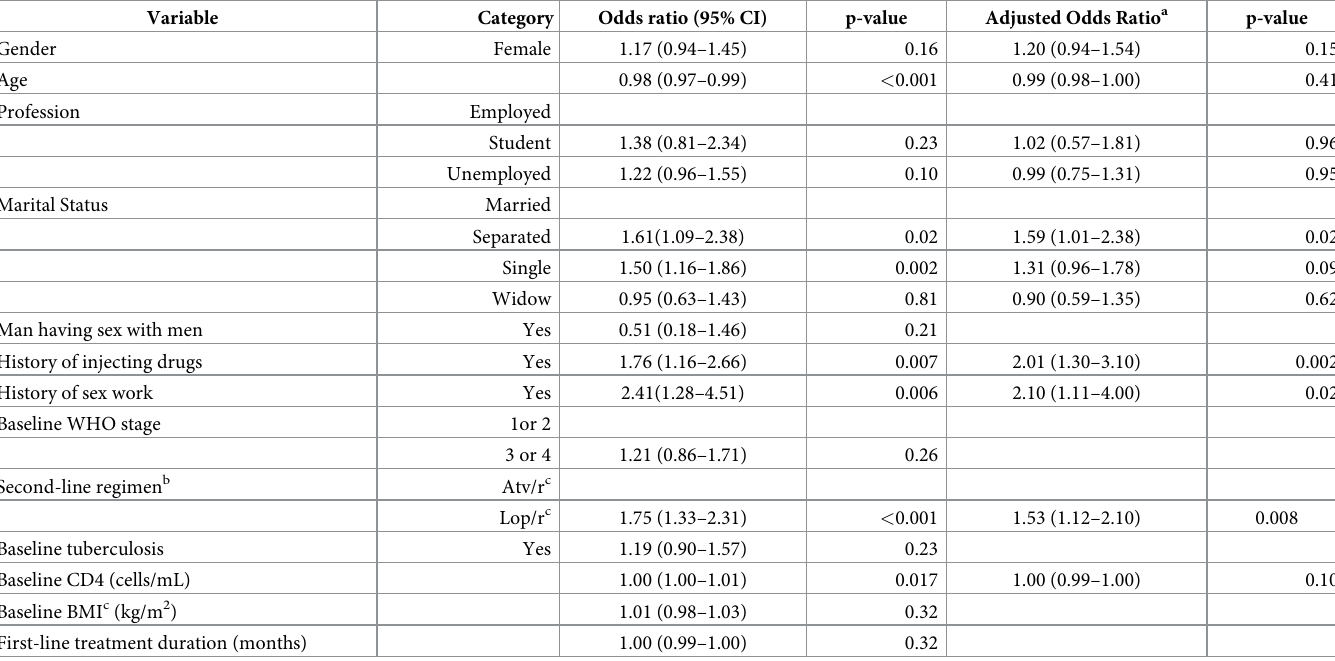
Table 3. Univariable and multivariable fractional logistic regression to show the association between explanatory variables and viraemia (N =